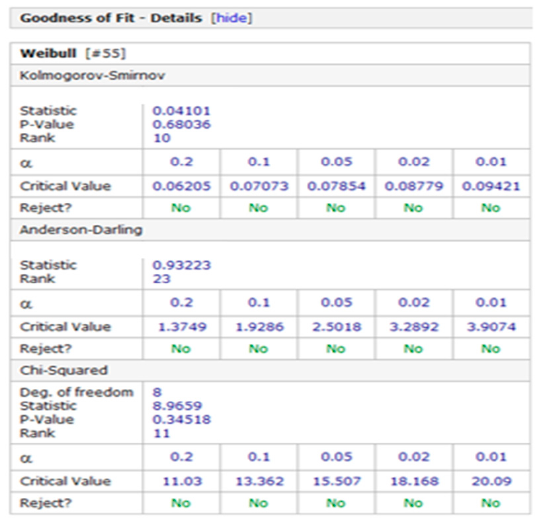
Figure 2. Probability destitution for ref. failure rate. Table 2. Simulation input parameters.